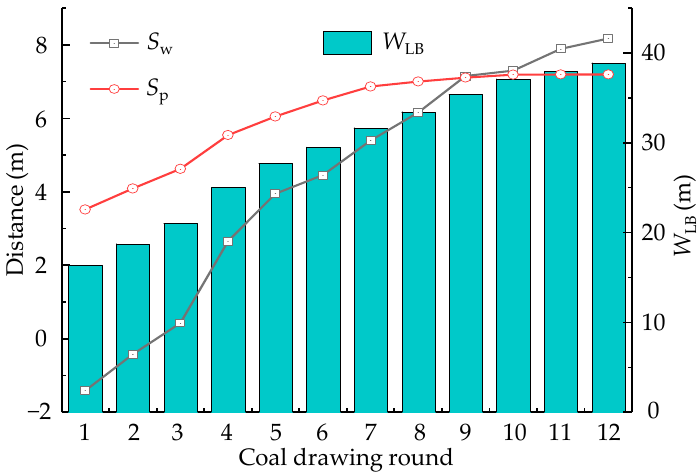
Coal drawing round Figure 9. Curve of LB advance distance evolution. Figure 9. Curve of LB advance distance evolution. Figure 9. Curve of LB advance distance evolution.